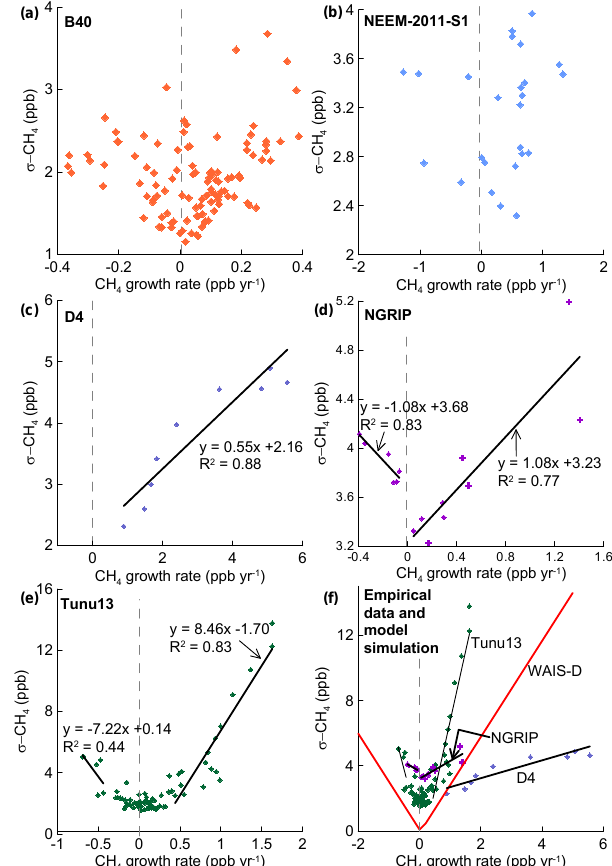
Figure 5. Relationship between CH 4 growth rate and high- frequency CH 4 variability ( σ -CH 4 ) in the following ice cores: B40 (a) , NEEM-2011-S1 (b) , D4 (c) , NGRIP (d) , Tunu13 (e) . σ - CH 4 is calculated every 10years for intervals of 40years duration (except for 5 NGRIP data points (cross symbols), which are discrete 10-year intervals with no overlap, due to poor core quality and dis- continuous record). Linear regression of growth rate and σ -CH 4 is displayed where appropriate. A linear fit is applied to Tunu13 and D4 data with growth rates > ± 0.4ppbyr − 1 and to NGRIP data with growth rates > ± 0.1ppbyr − 1 . Panel (f) displays data from Tunu13, D4 and NGRIP with firn air transport model output for the WAIS Divide ice core